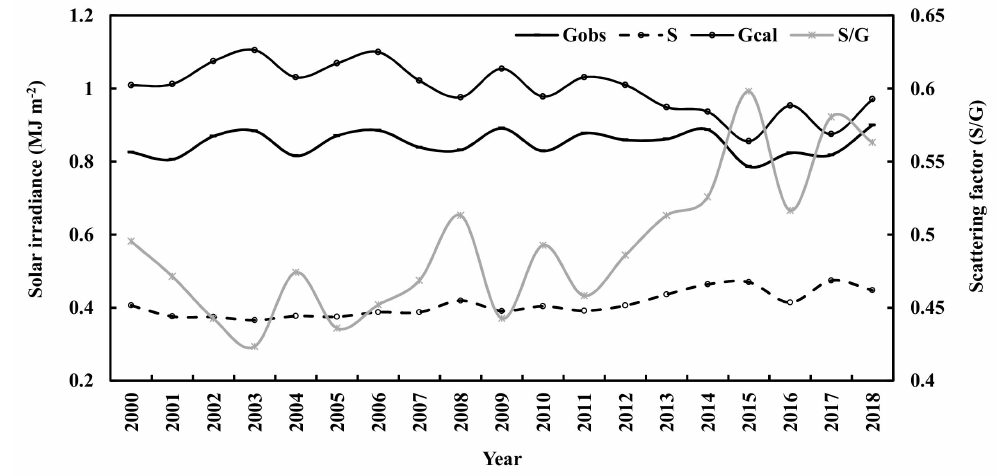
Figure 10. Annual averages of calculated and observed global solar irradiance, observed diffuse irradiance (S) and scattering factor (S/G) during